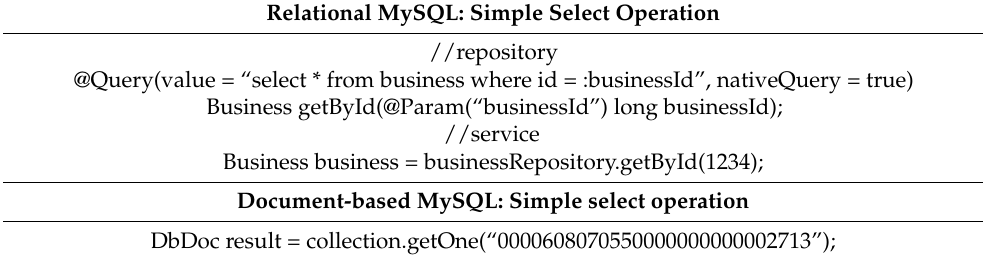
Table 8. Simple select